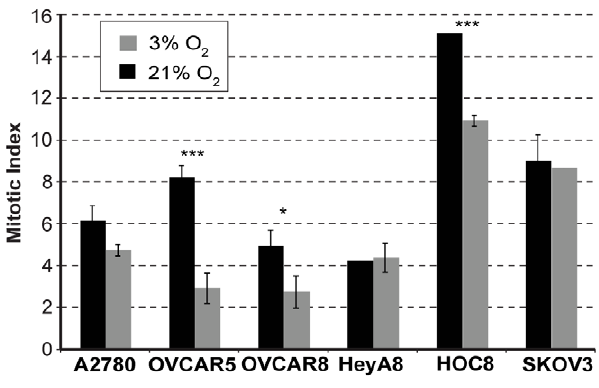
Figure 3. Mitotic index in the ovarian cancer cell lines grown under 3% or 21% O 2 . Mitotic index in the ovarian cancer cell lines that were cultured under 3% or 21% O 2 for 3 days were determined by counting nuclei with condensed chromosomes, among the minimum of 1000 cells present in each experiment. Statistical significance was determined by ANOVA and the significant difference in the mitotic index between 3% and 21% O 2 is denoted by an asterisk [(*) p , 0.05, (***) p ,